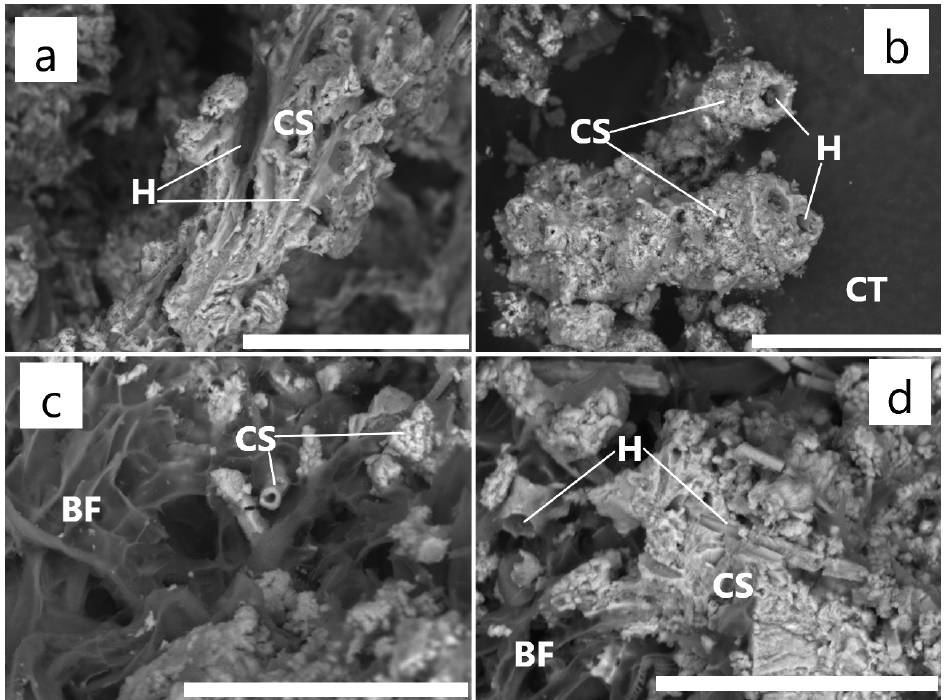
Figure 7. SEM images of carbonate sediments in the nature cyanobacterial biofilm: ( a )—cavities in the mass of dense carbonate sediment (sample LCS-50); ( b )—mineralized sheaths of filamentous cyanobacteria (BF/DCS-24); ( c )—biofilm EPS with mineralized inclusions in the form of thin covers (sample BF/DCS-25); ( d )—different diameter cavities in the mass of dense carbonate sediment (sample BF/DCS-25). Note: BF—biofilm, CS—carbonate sediments; CT—carbon tape; H—holes from the cyanobacterial trichomes. Scale bar 50 µ